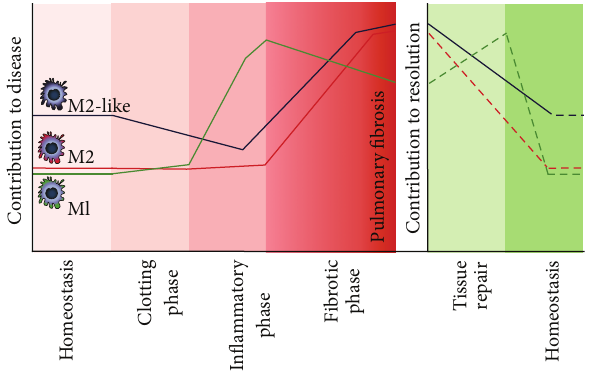
Figure 4: Schematic representation of the presence of M1, M2, and M2-like macrophages in lung tissue during homeostatic conditions and after injury to the lung. Normally after lung injury a process of tissue repair is initiated with four distinct phases leading to homeostatic conditions again. In lung fibrosis this normal tissue repair response is dysregulated leading to deposition of excess extracellular matrix and little resolution of scar